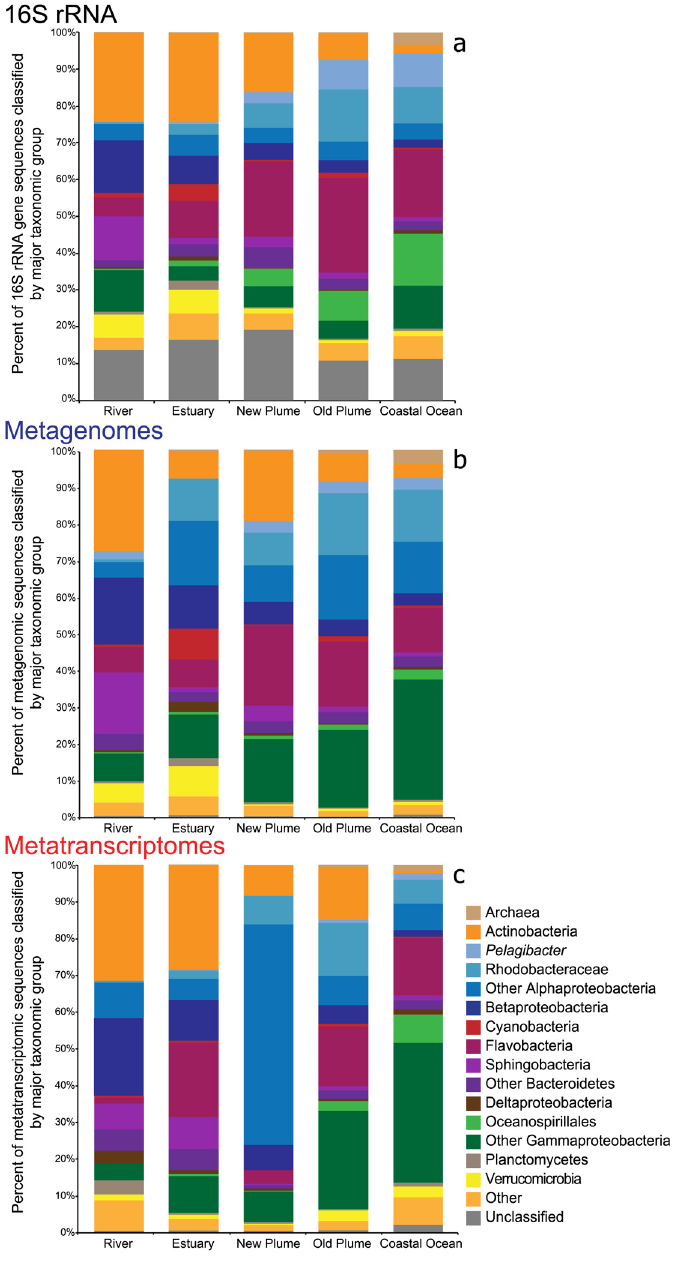
Fig 2. Taxonomic changes across the salinity gradient. Bar charts represent the taxonomic changes seen in a) 16S sequences identified from metagenomes, b) COG annotated sequences from metagenomes, and c) COG annotated sequences from